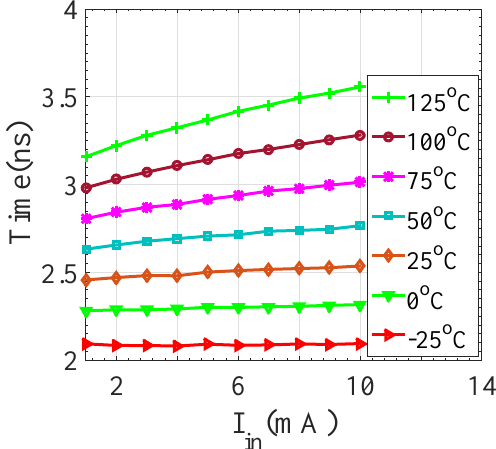
Figure 10. Simulated output delay vs.